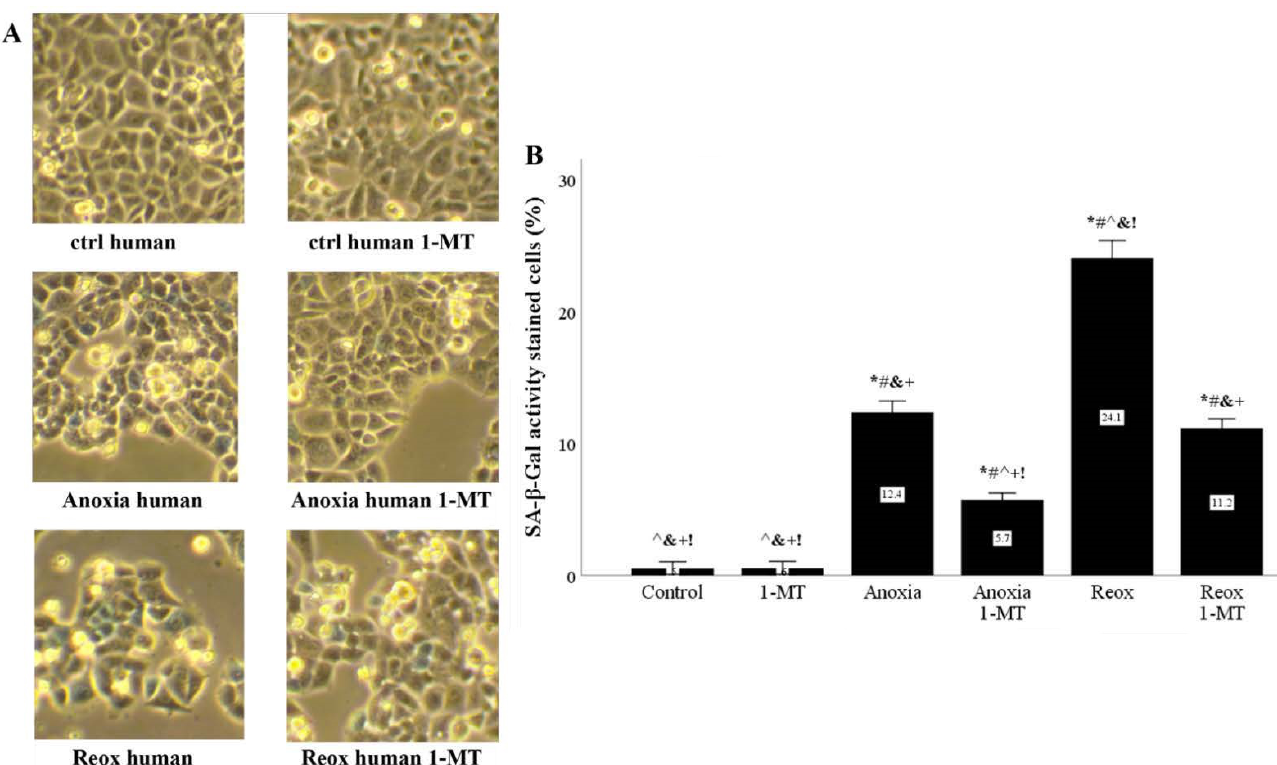
Figure 12. In human RPTECS, inhibition of IDO reduces anoxia- or reoxygenation-induced upregulation of SA- β -Gal activity. Primary human RPTECs were cultured under anoxia for 2 h or subjected to reoxygenation for another 24 h. A representative of three independent experiments is depicted in panel ( A ). Anoxia increased SA- β -Gal activity, which was further increased by reoxygenation. The IDO inhibitor 1-MT reduced both anoxia and reoxygenation-induced upregulation of SA- β -Gal activity ( B ). * p < 0.05 vs. Control, # p < 0.05 vs. Control with 1-MT, ^ p < 0.05 vs. Anoxia, & p < 0.05 vs. Anoxia with 1-MT, + p < 0.05 vs. Reox, ! p < 0.05 vs. Reox with 1-MT. Error bars correspond to SEM. 1-MT, 1-DL-methyltryptophan; Reox, reoxygenation; SA- β -Gal, senescence-associated β -galactosidase.